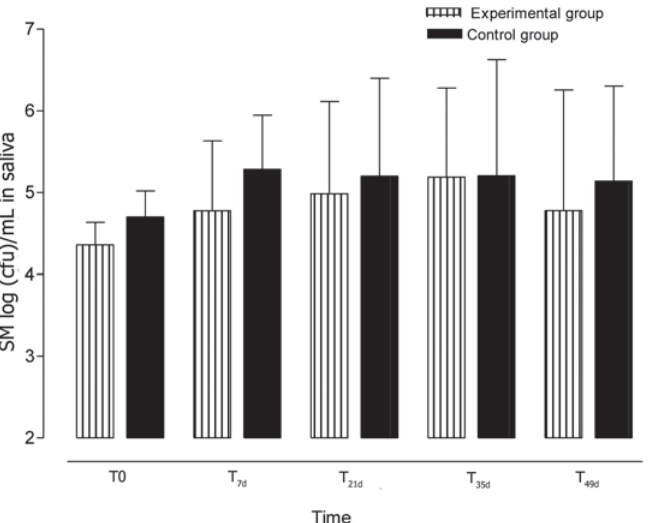
Figure 1- Means and standard deviations [log(cfu)/mL] of Streptococcus mutans in saliva for experimental (Fuji ORTHO LC) and control (Transbond XT) groups at different times of collection